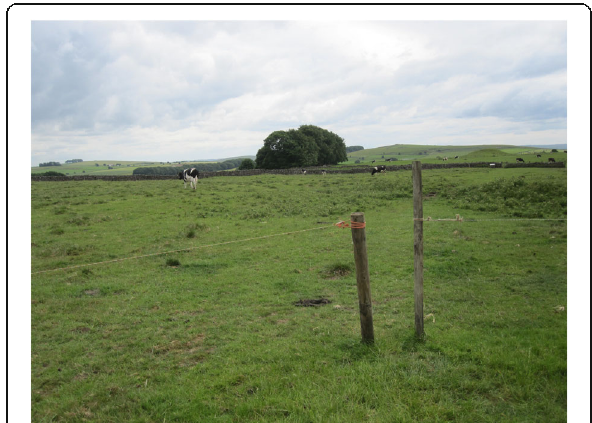
Fig. 3 This picture shows an effective barrier to the passage of the cows in the field who is deterred by the electric fence and the insufficient breadth of the opening between the wooden stakes. At the same time this same opening “ affords ” passage for human beings. The image is taken on the path between the pre-historic sites of Arbor Low and Gib Hill in Derbyshire England (Photograph by the